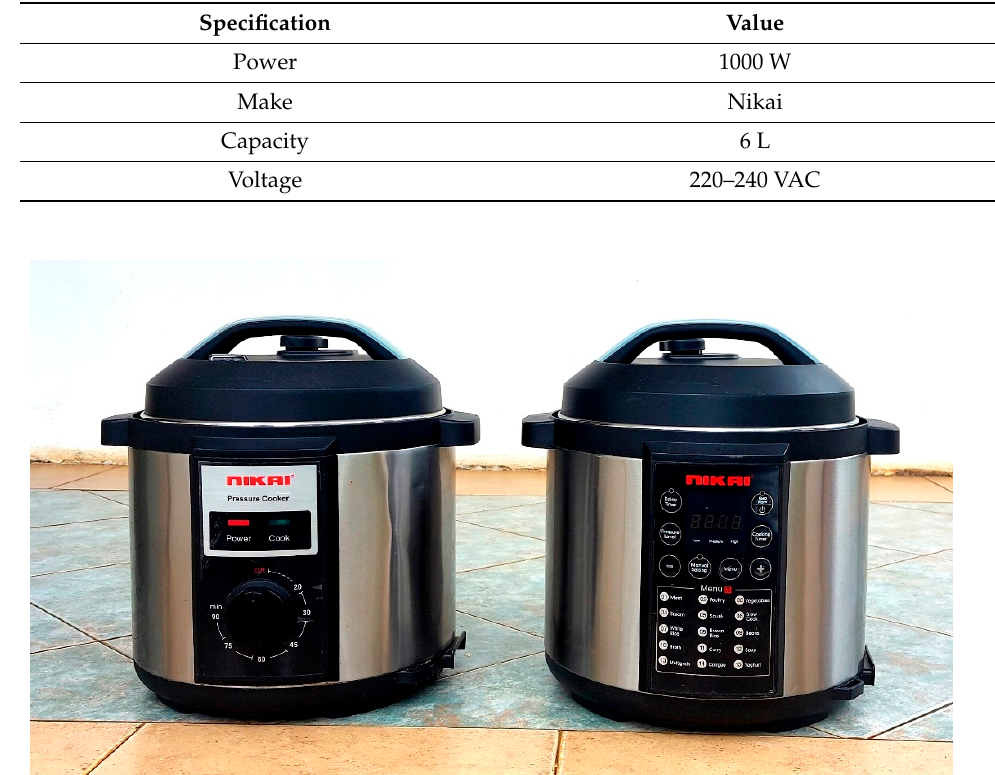
Figure 1. EPCs used in A2EI pilot.